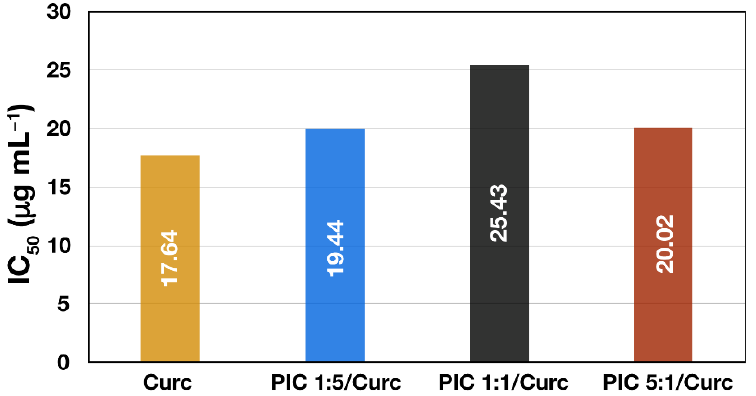
Figure 6. IC 50 values of DPPH• radical scavenging activity of free curcumin and curcumin-loaded PIC micelles prepared at different ratios between the oppositely charged groups of the hybrid block copolymers.